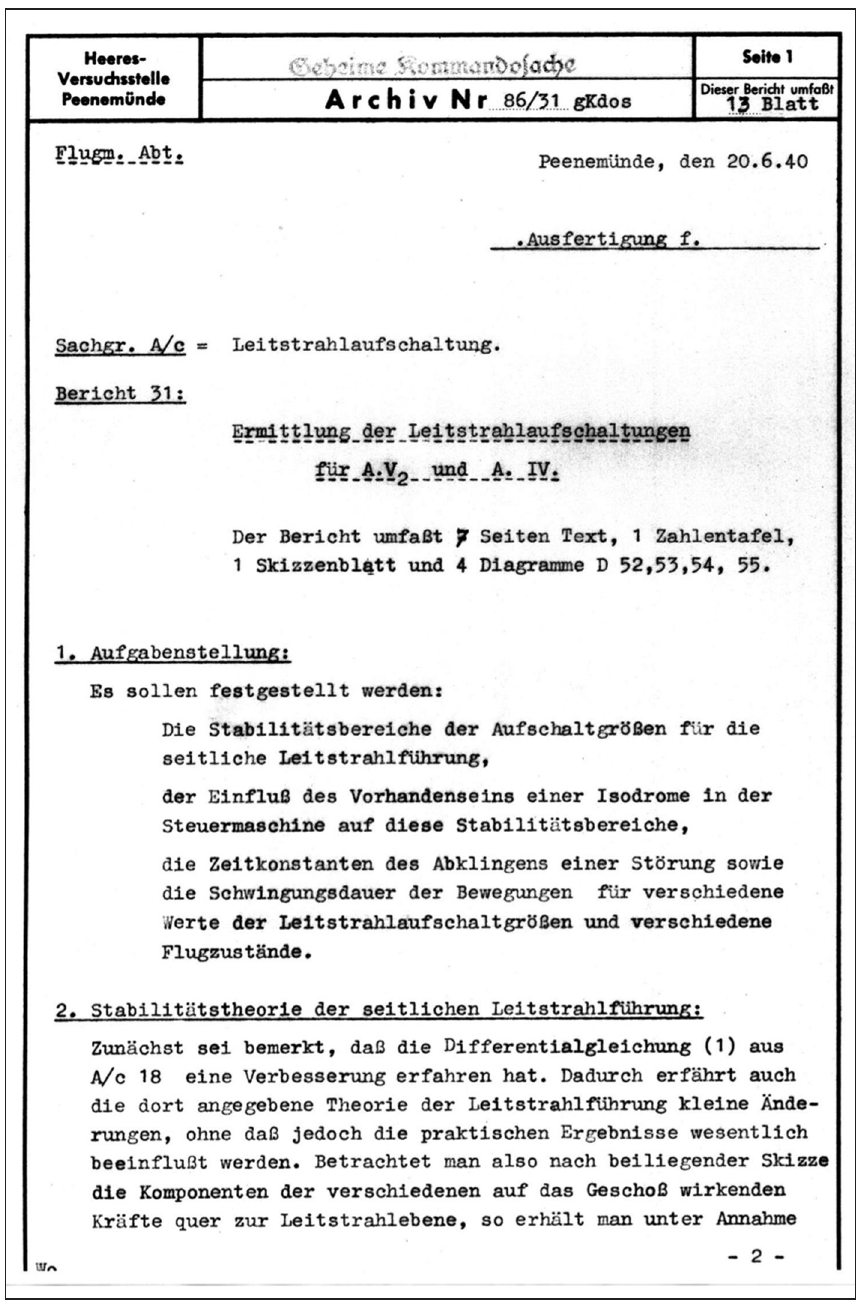
Figure 5: Document of the Heeresversuchsstelle Peenemünde . First page of a report on guidance beam coupling for the Aggregate 4 (V-2), with stamp ‘Geheime Kommandosache’ (ARCH 86/31). Reproduced with permission of the